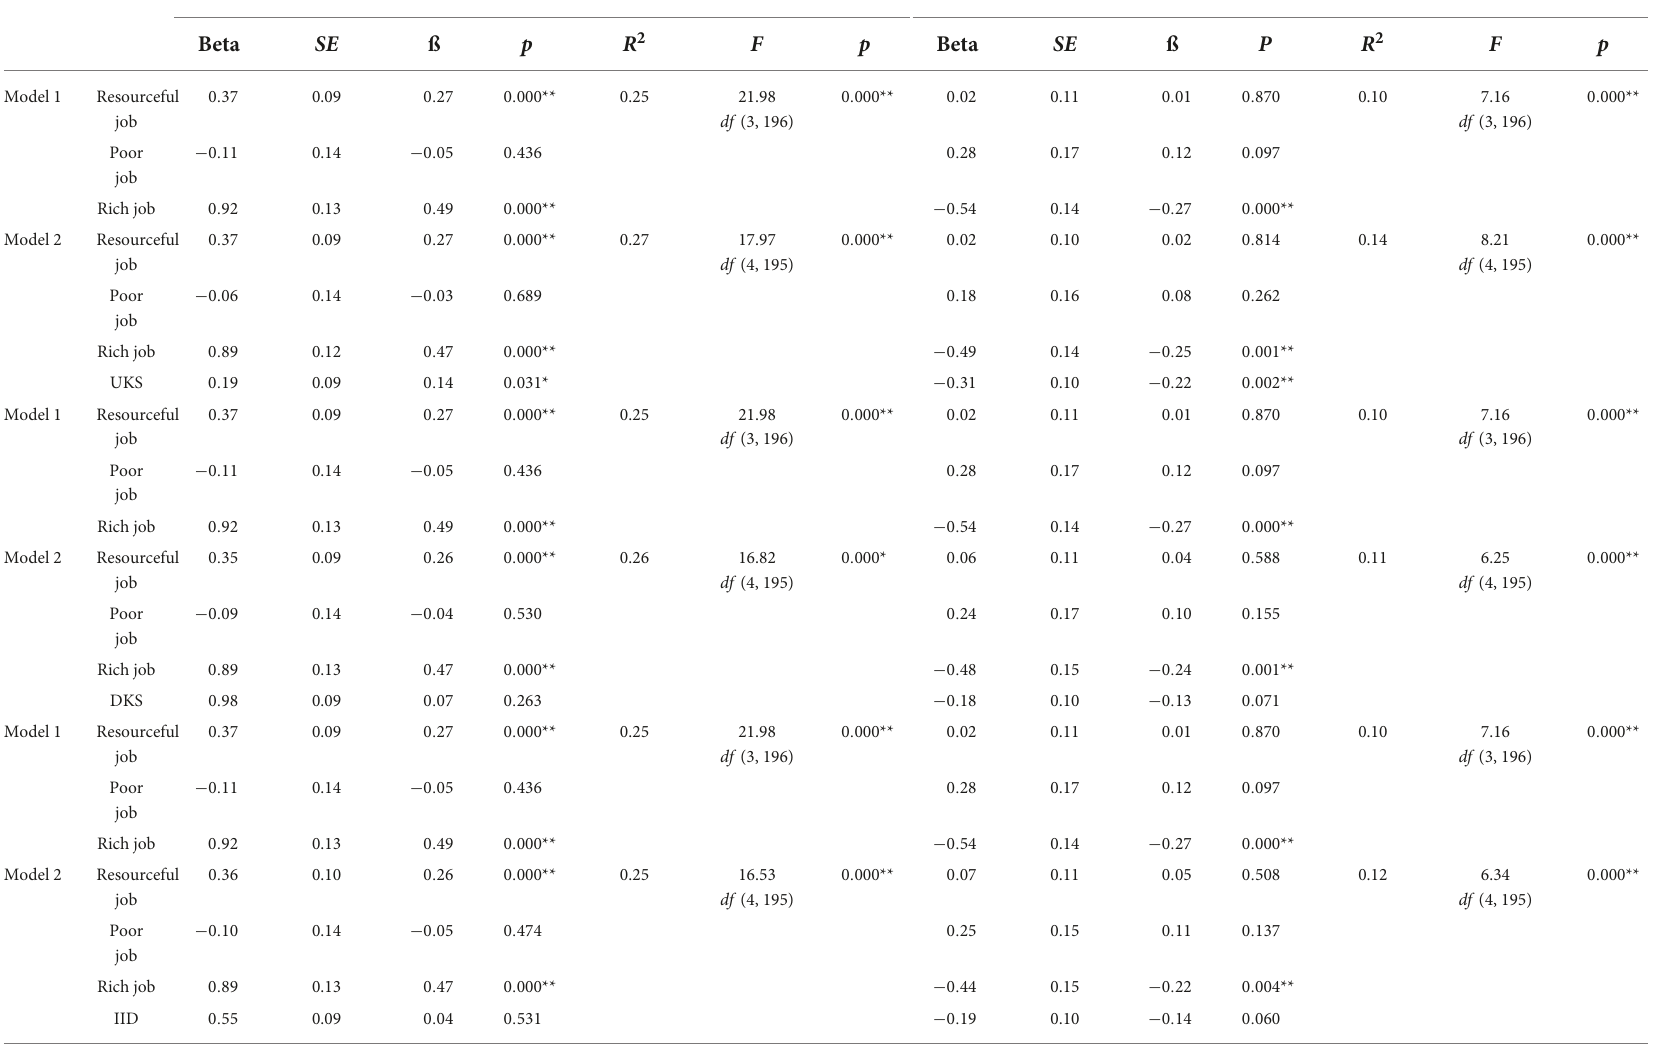
TABLE 6 Multiple regression analyses of the job demands-resources profiles and capabilities on work engagement and intention to leave. Model Variable Work engagement Intention to